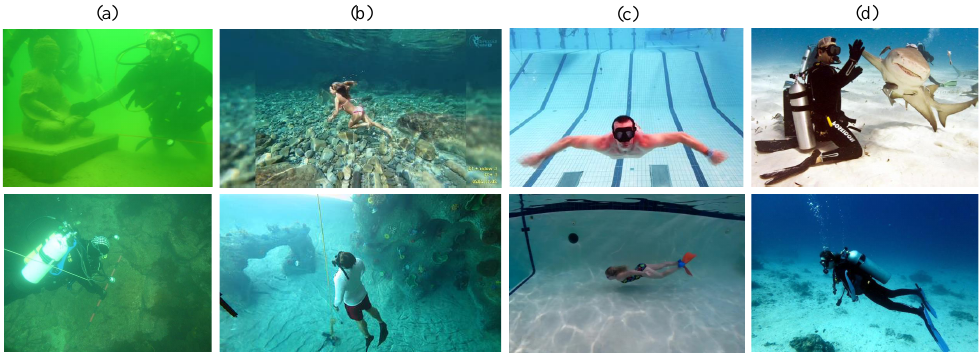
Figure 6. Different types of images in the Diver dataset are shown. ( a ) Green. ( b ) Blue. ( c ) Indoor. ( d )